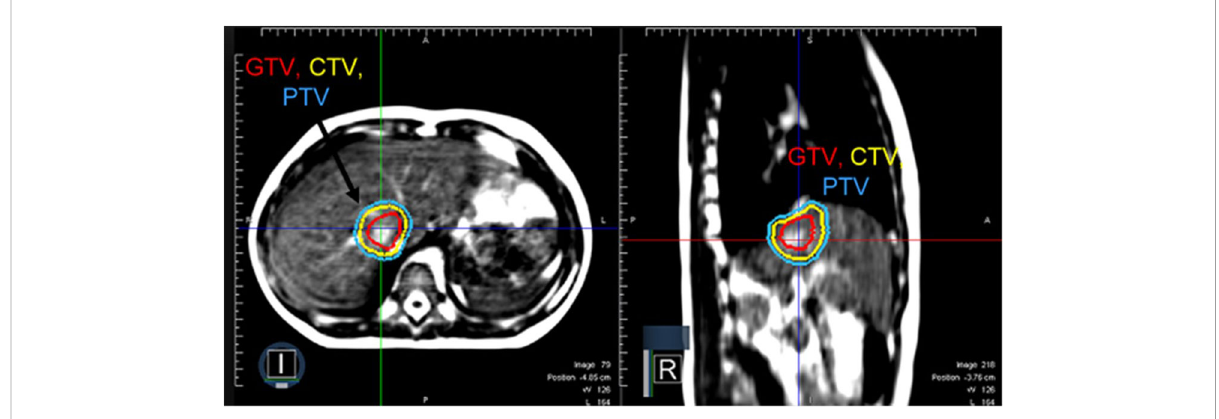
FIGURE 2 A patient with metastatic rhabdomyosarcoma with a solitary liver metastasis who received SABR using MRgRT. Continuous cine imaging and gated delivery during mid-inspiration breath hold enabled treatment with PTV expansion of 3 mm. No ITV was